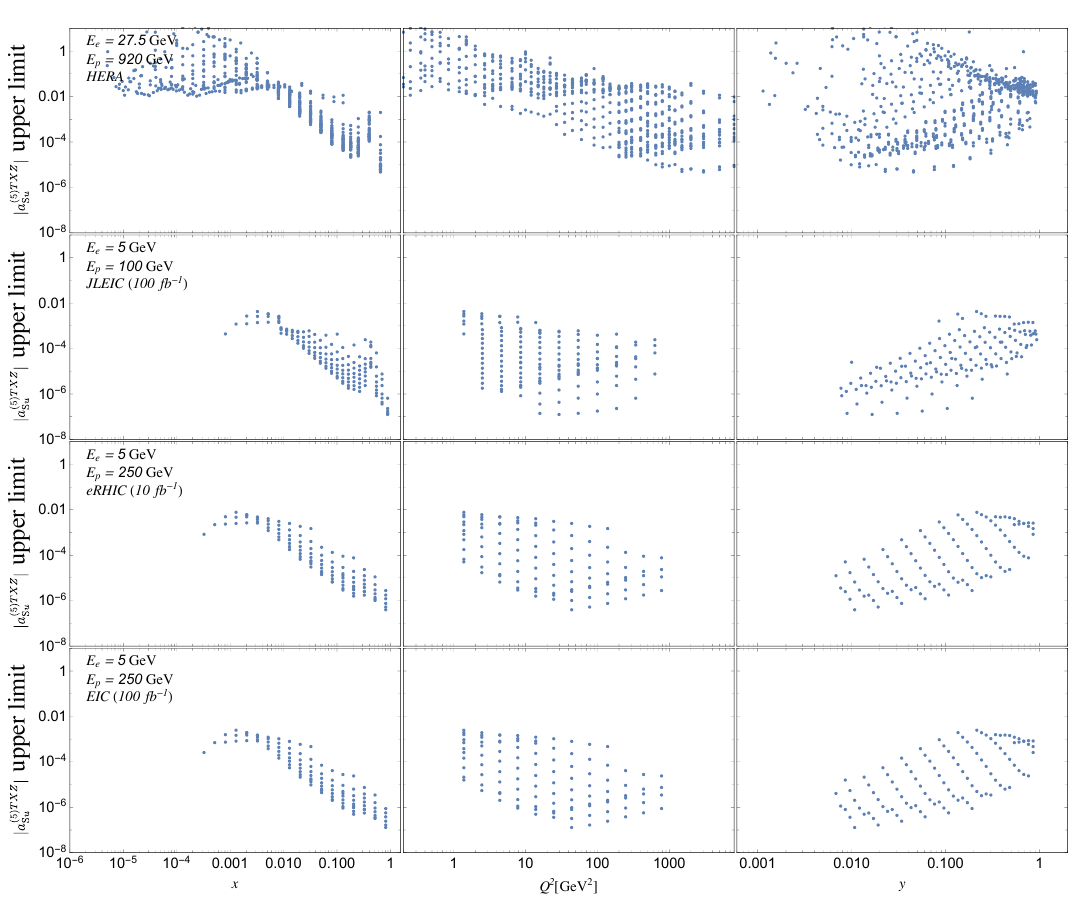
Figure 4 . Distribution of j a (5) TXZ j correlated upper sensitivities for HERA and for JLEIC and S u eRHIC in both initial and (cid:12)nal con(cid:12)gurations as functions of x , Q 2 and y related through Q 2 = xys